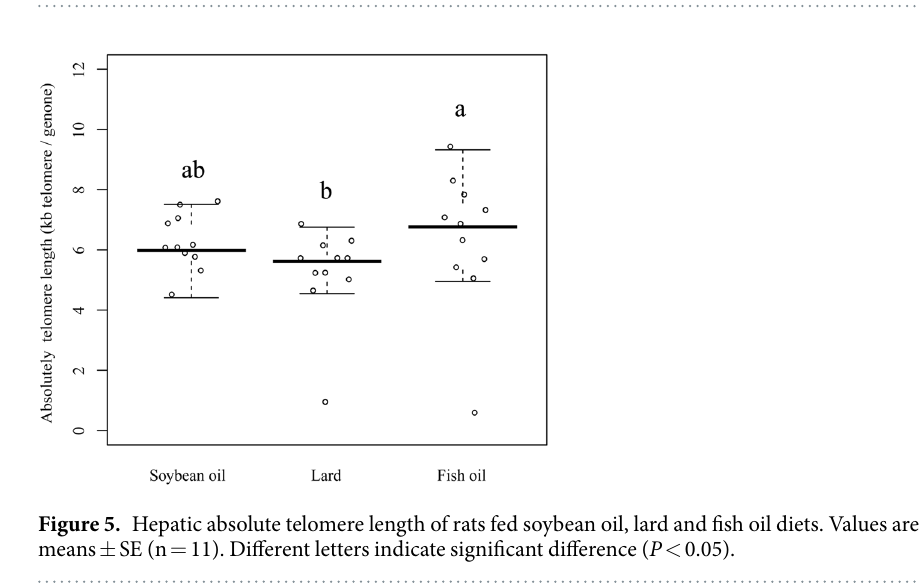
for the soybean oil group from any of the other two groups ( P > 0.05). Thus, intake of fish oil may retard telomere attrition for the middle-aged rats as compared to the intake of lard.